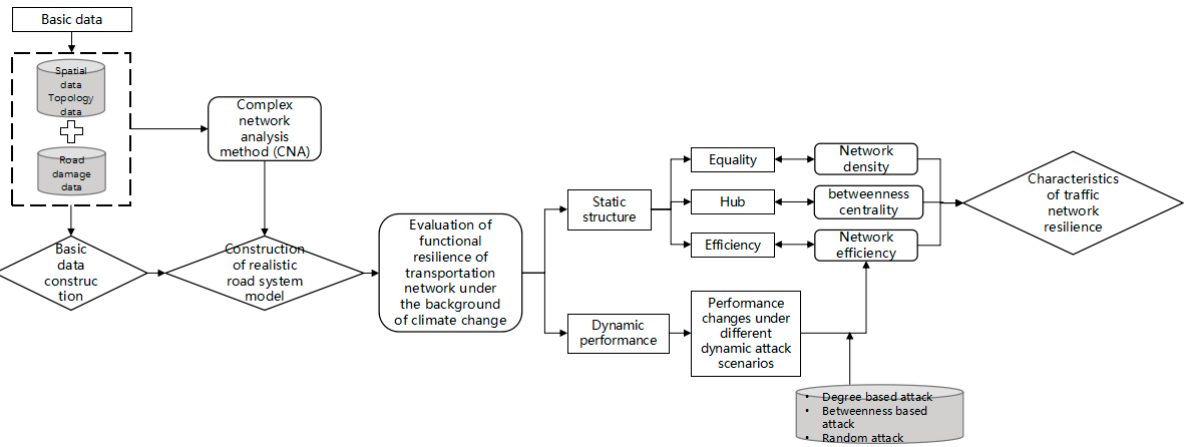
Figure 2. Technical procedure route (Source: self-drawn by the